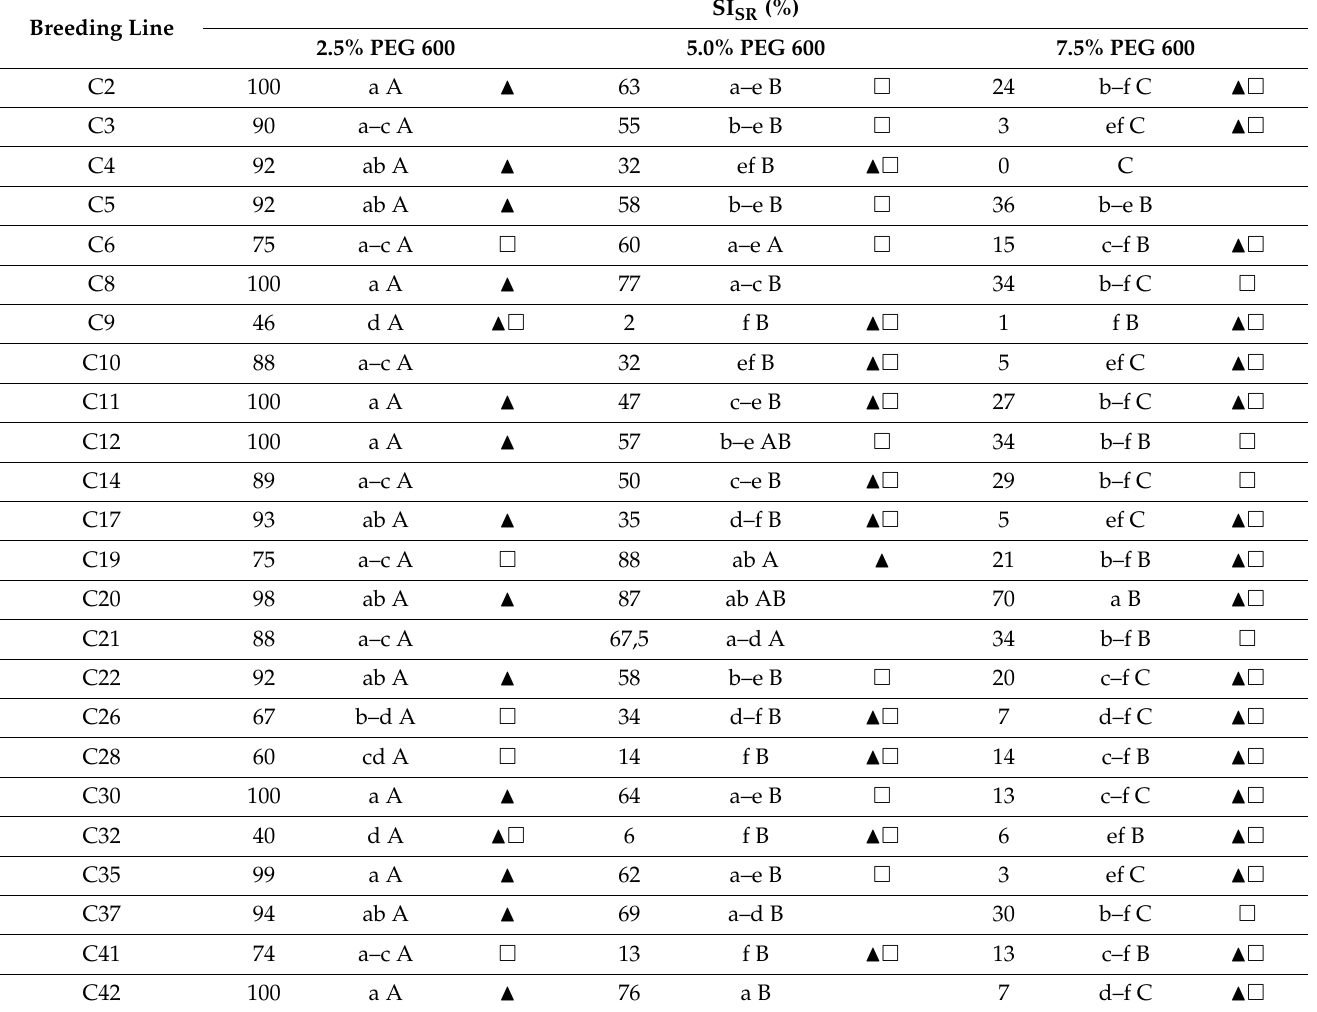
Table 6. Survival rate SI (SI SR ) values of potato genotypes under osmotic stress induced by PEG 600 added to the medium at level of 2.5%, 5.0% and